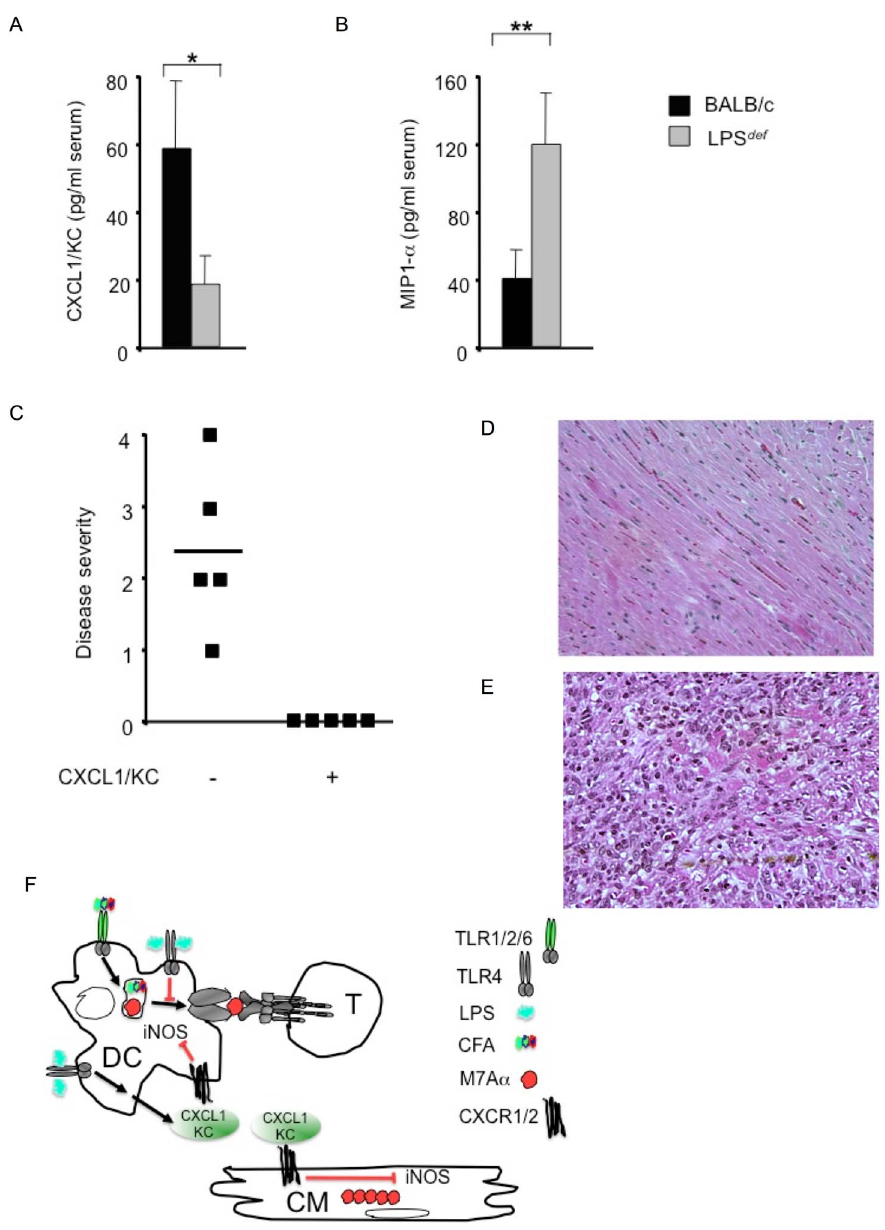
Figure 4. The chemokine CXCL1/KC abrogates experimental autoimmune myocarditis in mice. (A) Severe inflammation in the myocardium was accompanied by persistent presence of the chemokine MIP1 a . (B) CXCL1/KC was significantly elevated in the serum of wild type BALB/c mice and significantly reduced in the serum of LPS def mice. Serum chemokine concentrations were determined 21 days after the initial immunization with heart-specific M7A a peptide in CFA (5 mice per group, Mean value 6 SD). (C) Therapeutic administration of mouse recombinant chemokine CXCL1/KC, after experimental challenge with heart-specific M7A a peptide in CFA, abrogated heart inflammatory infiltrate and heart muscle damage. Squares represent individual mice, lines indicate mean values. (D) Bland histopathologic picture in a representative heart section from a mouse treated with mouse recombinant chemokine CXCL1/KC after challenge with M7A a peptide in CFA. Original magnifications x10 is shown. (E) Severe myocarditis in a heart section from a control mouse injected with saline after challenge with M7A a peptide in CFA. Original magnifications x30 is shown Hearts were analyzed 21 days after the initial immunization with heart-specific M7A a peptide in CFA. Staining was with hematoxylin and eosin (H&E). Mice were immunized with heart-specific M7A a peptide in CFA and heart histopathology was determined at day 21 after the initial immunization. One result representative of 5 independent experiments is shown. (F) Cartoon outlining the mode of action by systemic LPS and CXCL1/KC in EAM. M7A a peptide and CFA co-localize within the phagosme where M7A a peptide is processed for presentation in conjunction with MHC class II molecules. TLR4 is dispensable for auto-antigen processing and presentation, TLR4, in fact, inhibits this process which, in turn, limits the autoantigen dependent expansion of pathogenetic T effs . TLR4 promotes the production of CXCL1/KC in EAM; and CXCL1/KC is cardioprotective as exemplified by its prevention of iNOS protein induction. T, effector T lymphocyte; DC, antigen presenting dendritic cell; CM